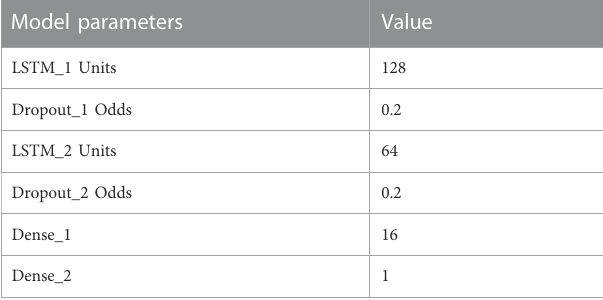
TABLE 1 Parameters of LSTM. Model